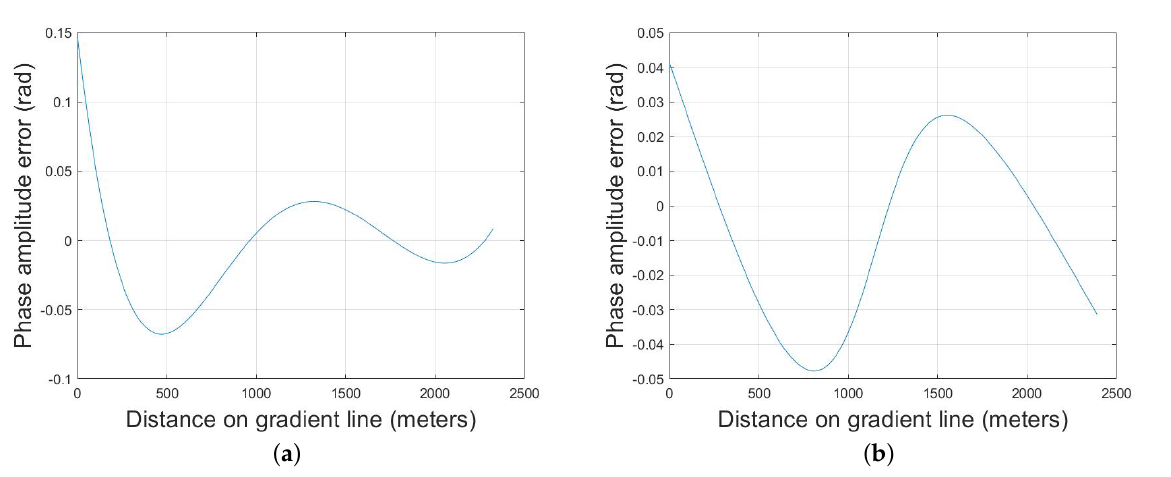
Figure 9. The difference between the fitted value and the true value of the parameter on the gradient. ( a ) is the result of amplitude. ( b ) is the result of the initial phase.